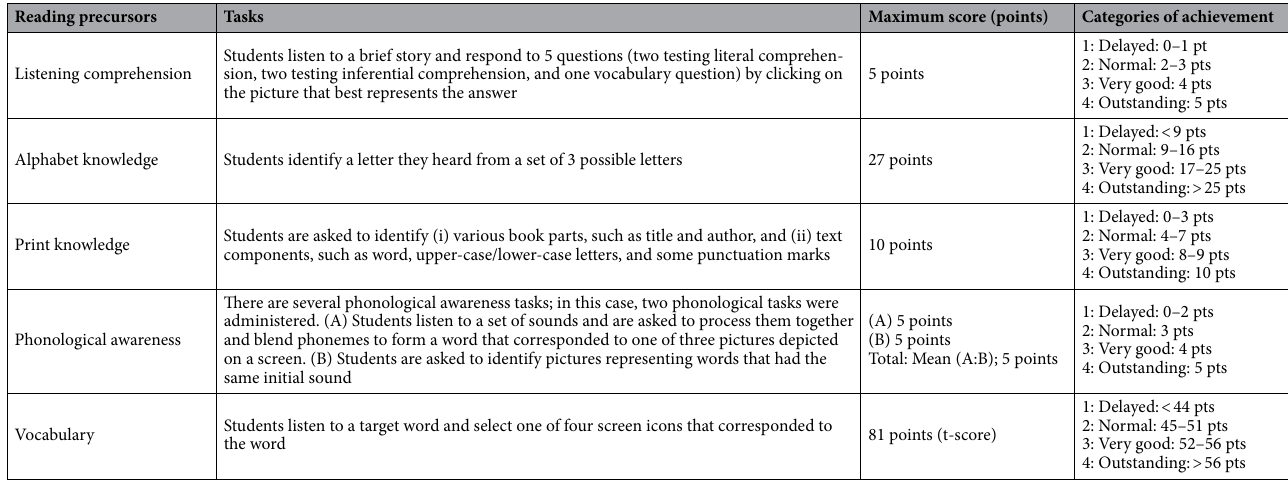
Table 3. Pre-Reading skills assessed by DIALECT